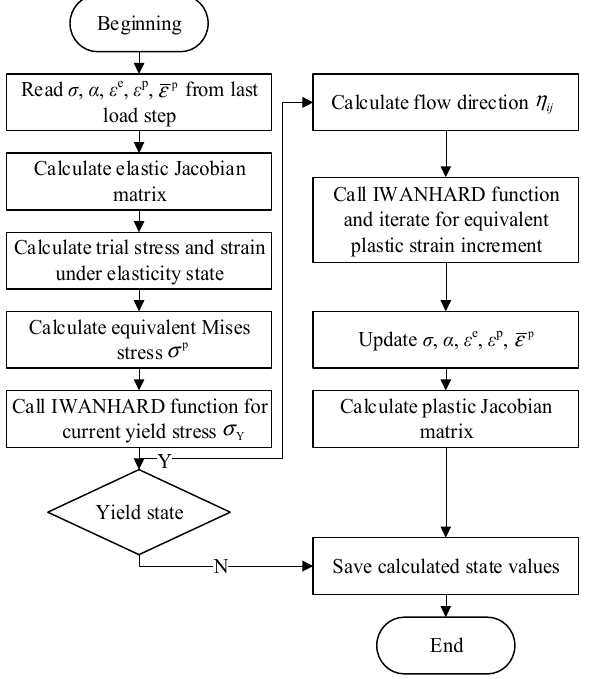
Figure 3. Flow chart of the proposed modeling